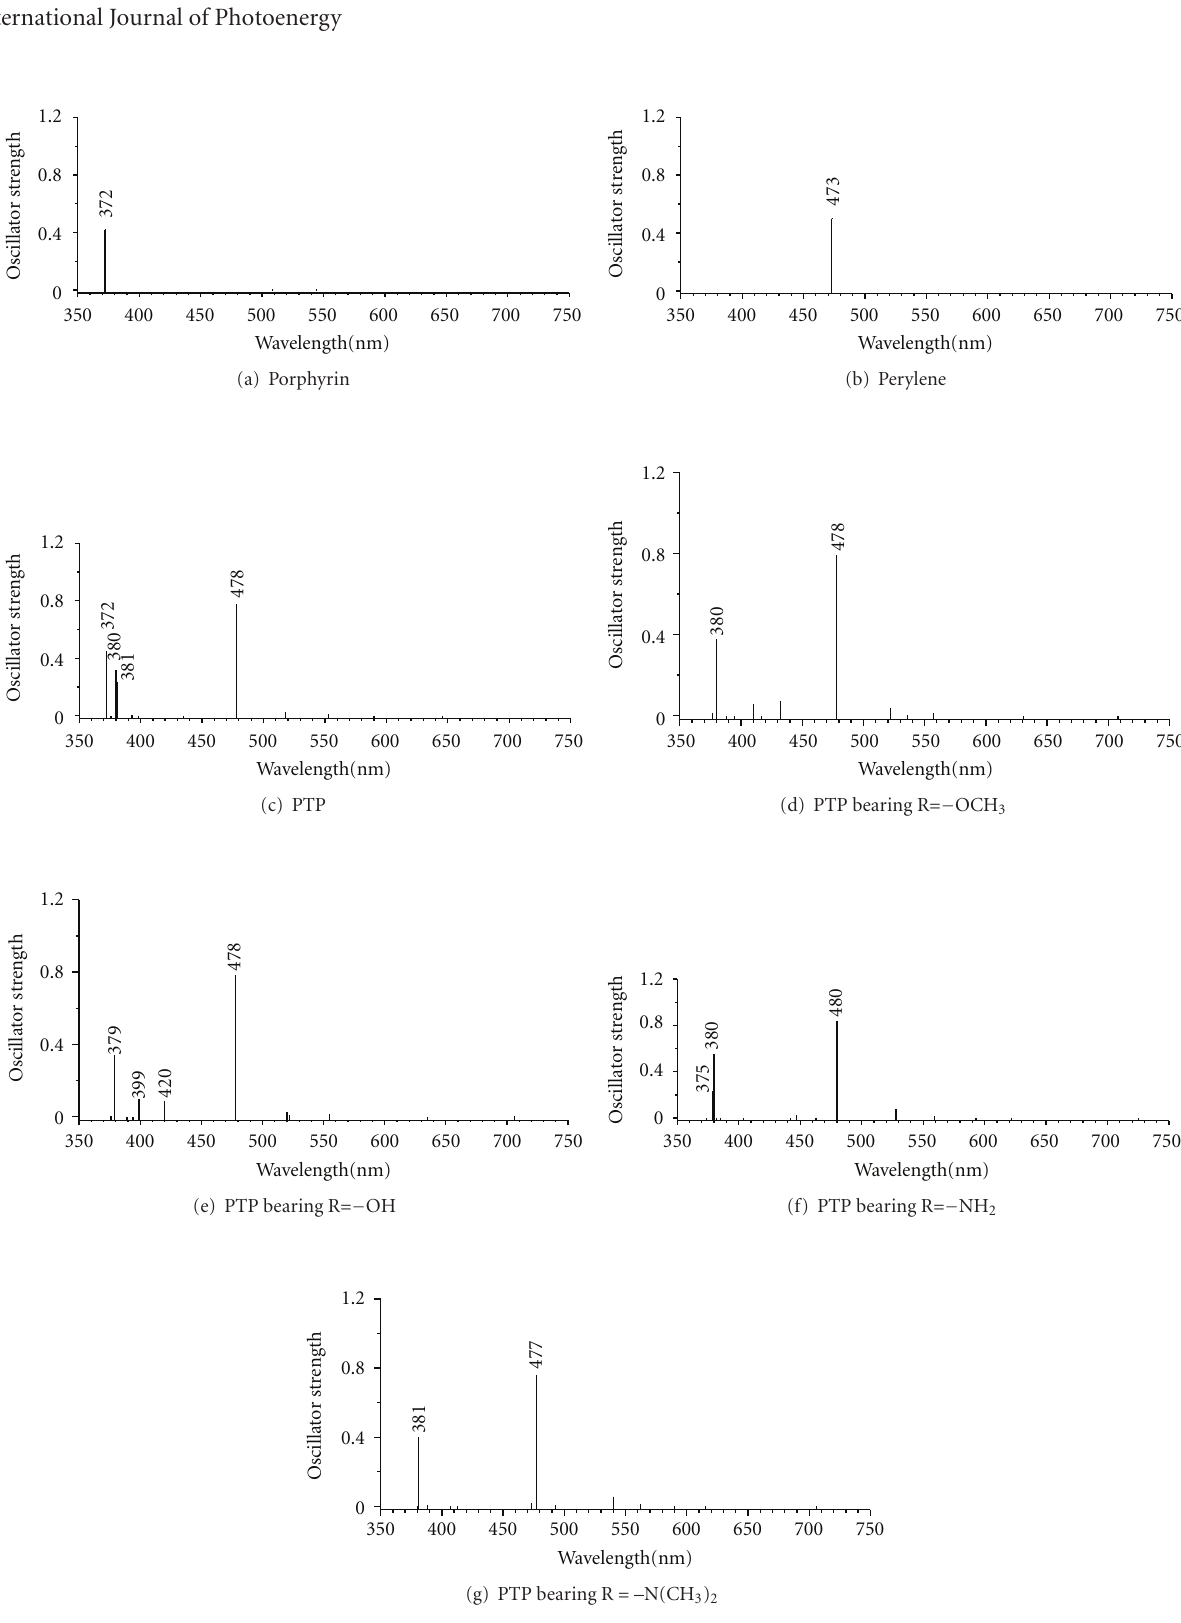
Figure 6: UV-visible spectra of the free-base porphyrin, perylene, PTP compound (R = R (cid:2) = –H), and the four newly designed derivatives which provide a significantly lower energy gap, relative to those of the PTP compounds, (marked as bold characters in Table